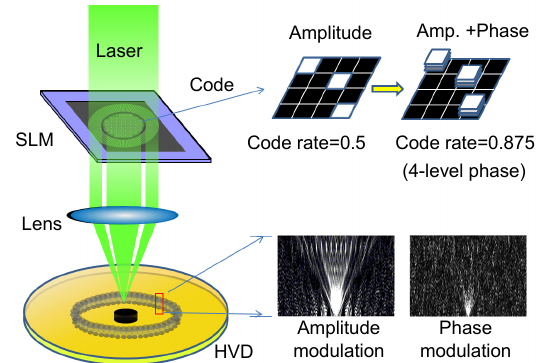
Fig. 5 | The comparison between amplitude modulation and phase